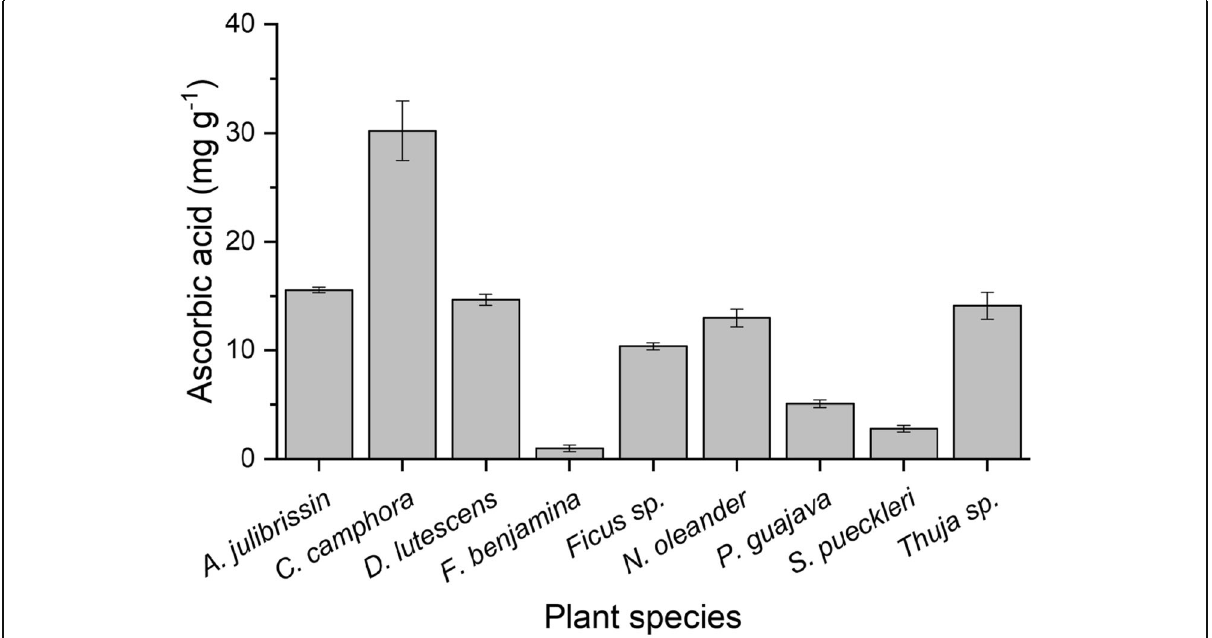
Fig. 5 Average ascorbic acid of the selected plant species; error bars represent the standard deviation ( n =